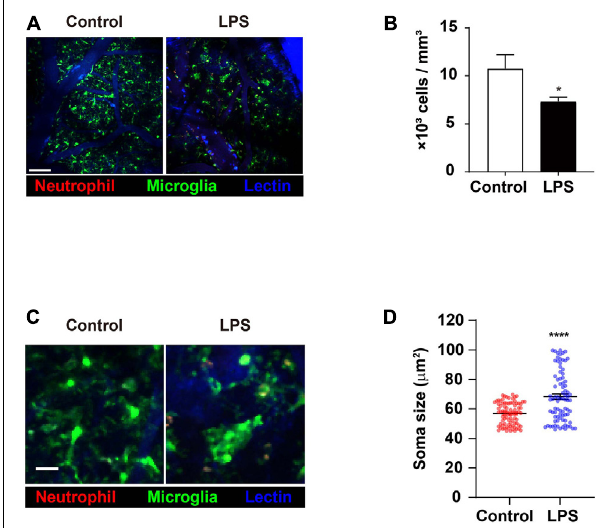
FIGURE 2 | Numerical reduction and morphological shortening of microglia in LPS-treated mice. CX 3 CR1 GFP / + mice were used to visualize microglia (green) in brain parenchyma using TPIM. CF405M-conjugated lectin was i.v. injected to stain blood vessels (blue). PE-conjugated anti-Ly6G antibody was i.v. injected to label neutrophils (red). (A) Representative images from brains of mice injected with PBS (control) and LPS, respectively (see Supplementary Video 3 ). Scale bar, 100 µ m. (B) Measurement of microglia numbers. Data indicate mean ± SEM using Student’s t -test (* p < 0.05, n = 3 mice per group of three independent experiments). (C) Representative image showing difference in microglial morphologies between control and LPS groups. Scale bar, 30 µ m (see Supplementary Video 4 ). (D) Quantification of microglia soma size. Data indicate mean ± SEM using Student’s t -test (**** p <